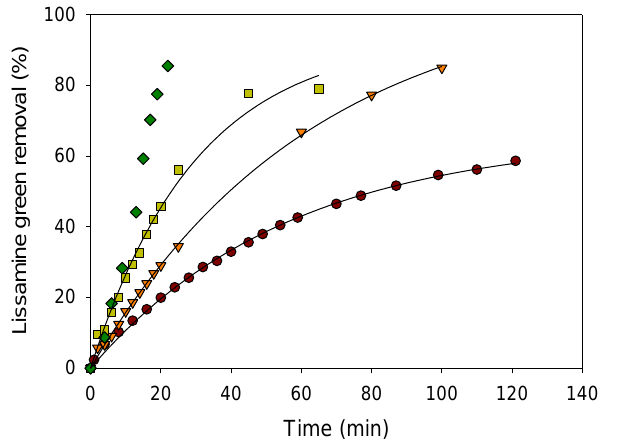
Figure 6. Effect of catalyst dosage on lissamine green removal: 0 g·L −1 (●), 5 g·L −1 ( ▼ ), 10 g·L −1 ( ■ ), 30 g·L −1 ( ♦ ). Line (-) represents the fit of the experimental data to a pseudo -first order kinetic equation. Experimental conditions: lissamine green = 7.5 mg·L −1 , PS = 1 mM.